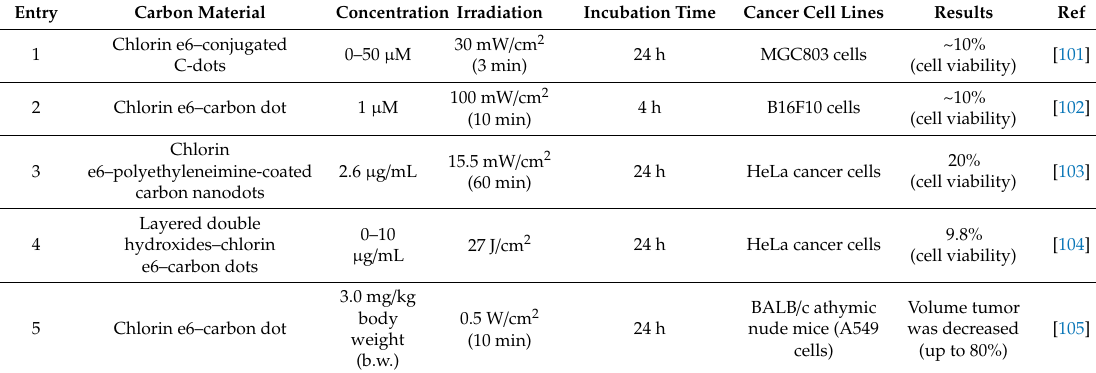
Parameters used for chlorin-based photosensitizers immobilized on carbon dots as photosensitizers against